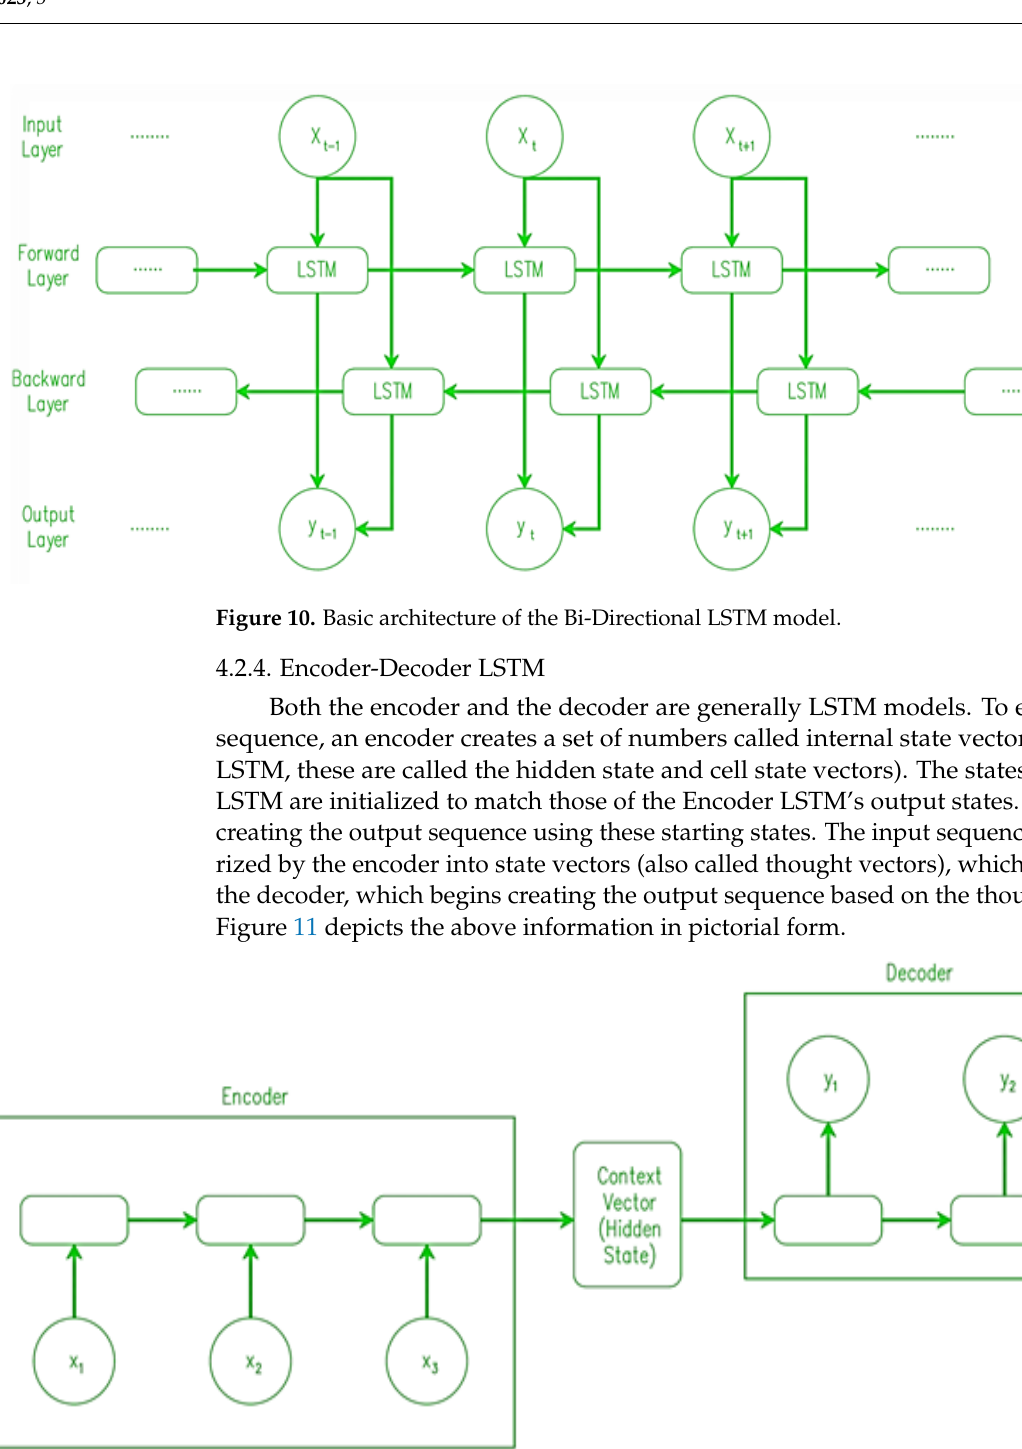
16 Figure 9. Basic architecture of the stacked LSTM model. 4.2.3. Bi-Directional LSTM